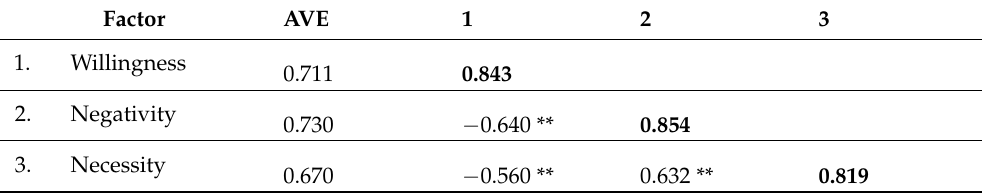
Table 3. Average variance extracted, square root of AVE, and matrix of correlations between factors for CPLAS.